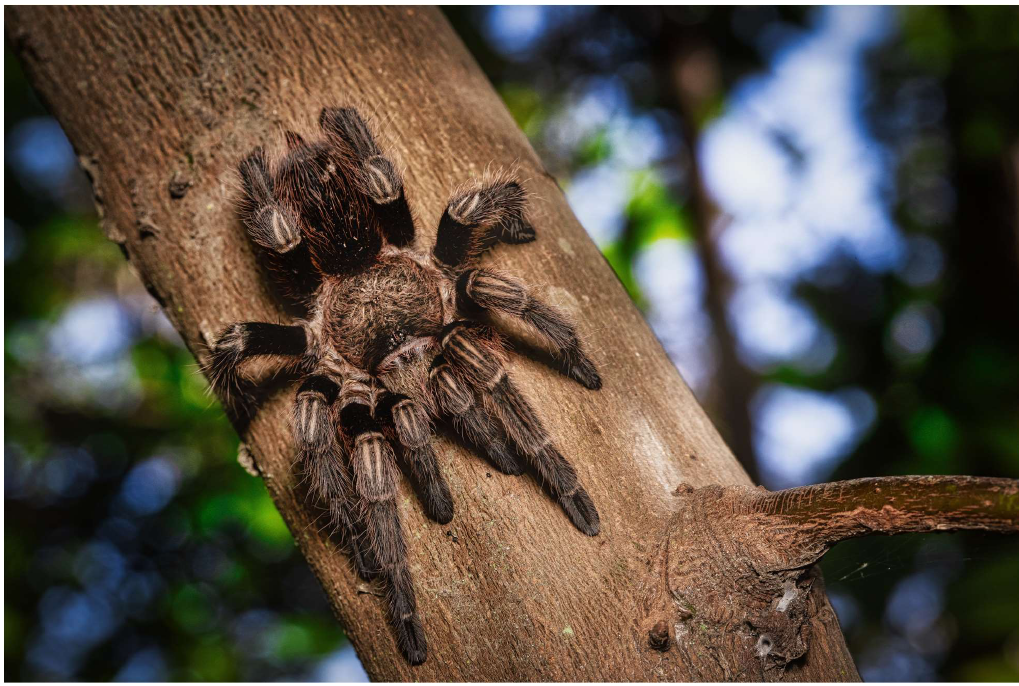
Figure 2. Euathlus sp. on a tree at 1.8 m high. La Campana National Park, Valparaíso region, Chile. Photo credit: Felipe Rabanal.